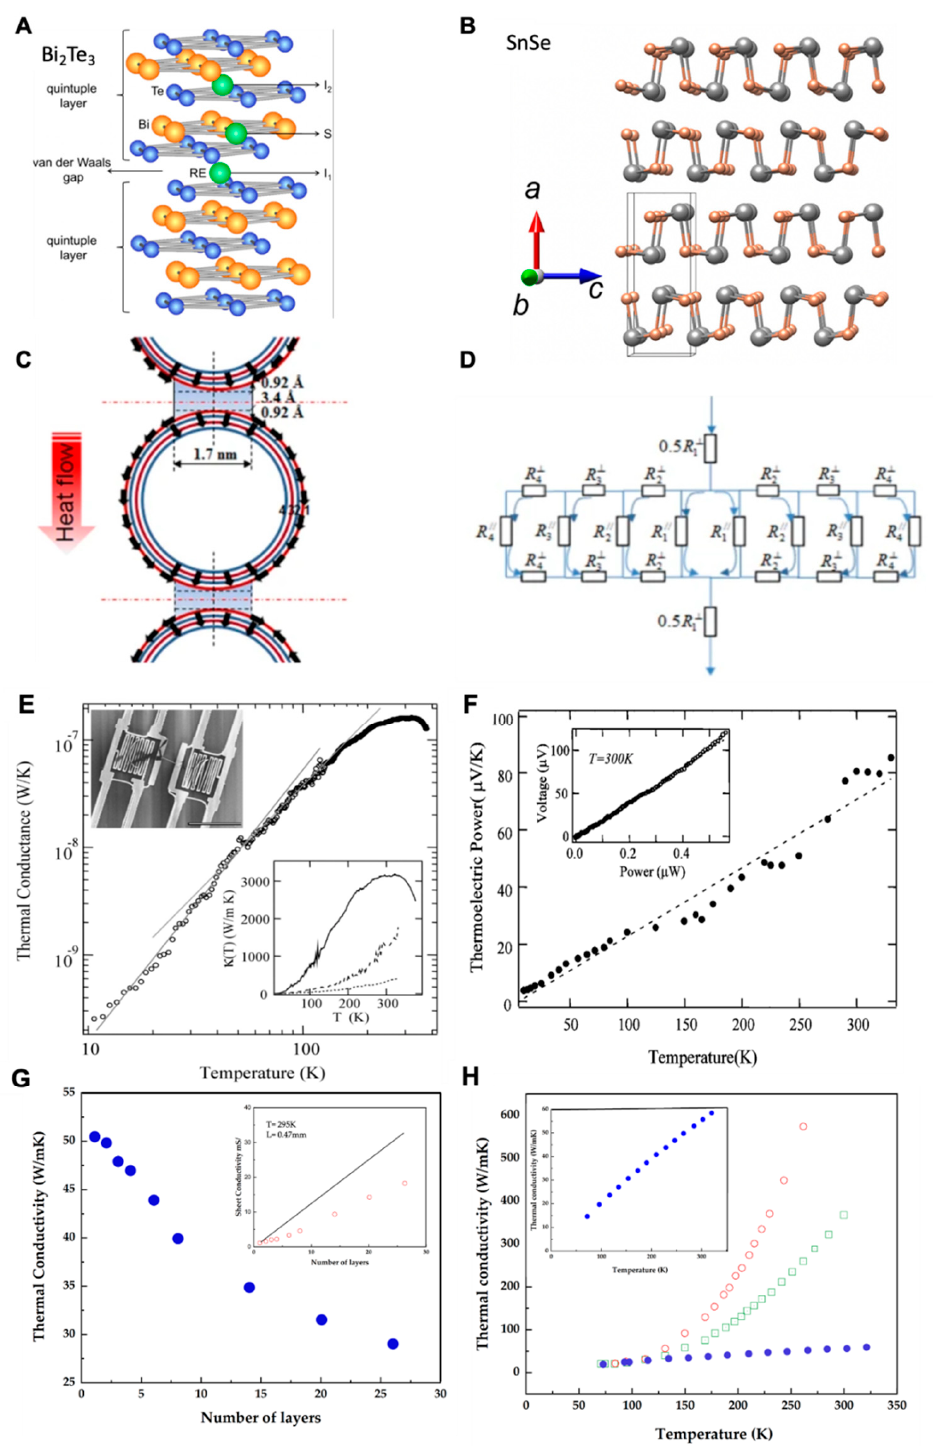
Figure 5. ( A ) The crystal structures of thermoelectric materials Bi 2 Te 3 ((Bi = orange, Te = blue) reprinted from [71] published under creative common license, 2016, Scientific Reports; ( B ) SnSe (gray = Sn, yellow = Se), reprinted from [72], copyright (2018), Liu, S.; Sun, N.; Liu, M.; Sucharitakul, S.; Gao, X.P.A. with permission from AIP Publishing; ( C , D ) the phonon transfer and thermal conductivity phenomena in CNTs; ( C ) thermal resistances at the different layers of MWCNTs; ( D ) intra-shell and inter-shell thermal resistance network as an electrically equivalent circuit of resistors to explain the thermal resistances in CNT network, “reprinted from [80] Thermal Transport Measure-